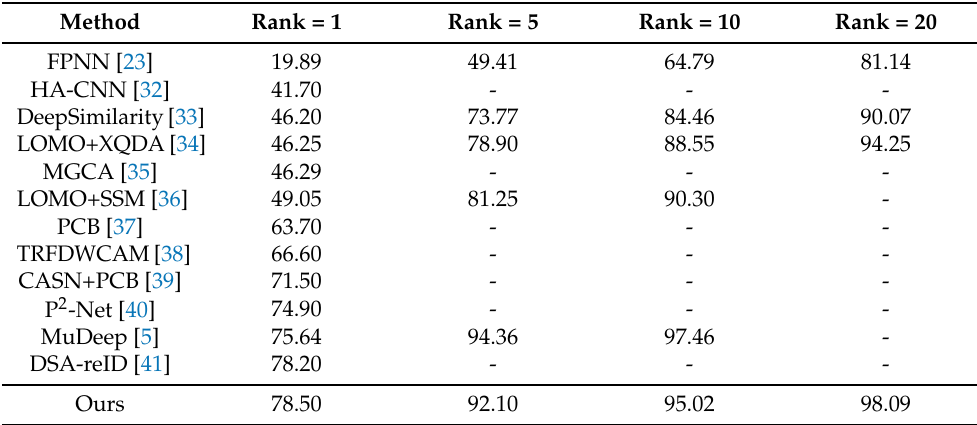
Table 2. Experimental results for CUHK-03 on the detected version.